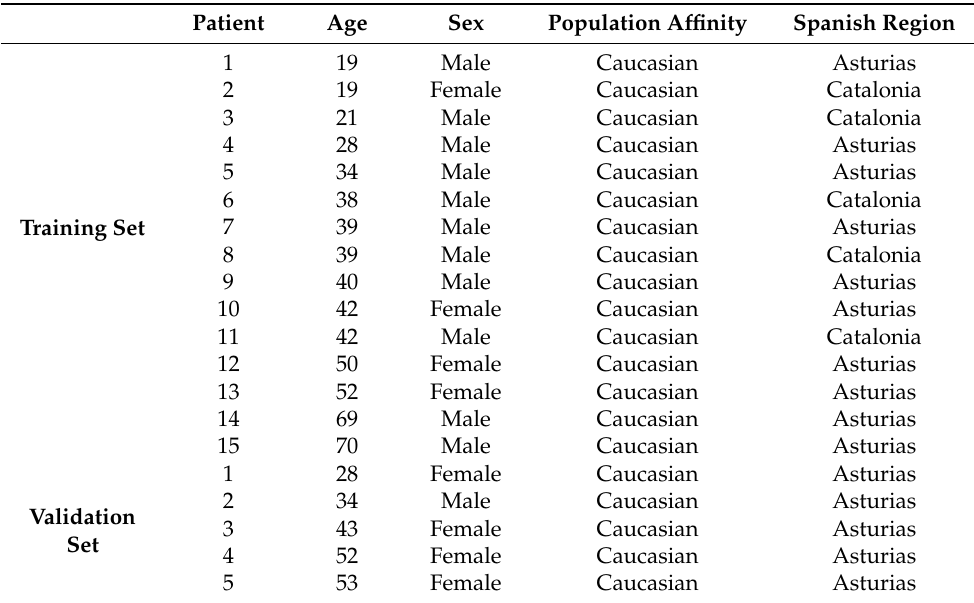
Table 1. Description of teeth samples used in this study including age, sex, population affinity and Spanish